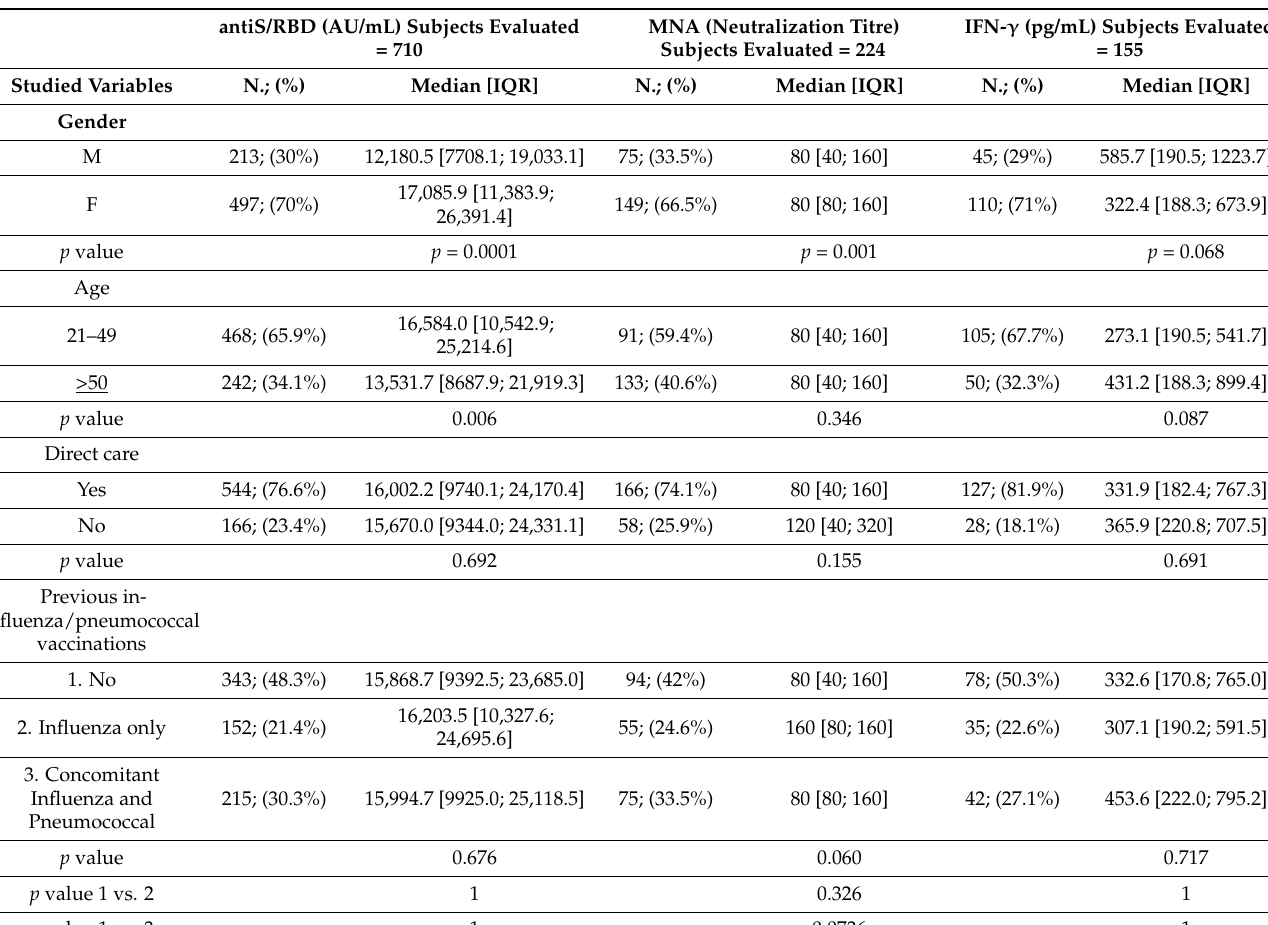
Table 1. Anti-S/RBD, MNA, and IFN- γ titers to BNT162b2 SARS-CoV-2 vaccine, according to studied variables. antiS/RBD (AU/mL) Subjects Evaluated MNA (Neutralization Titre) IFN- γ (pg/mL) Subjects Evaluated = 710 Subjects Evaluated = 224 =